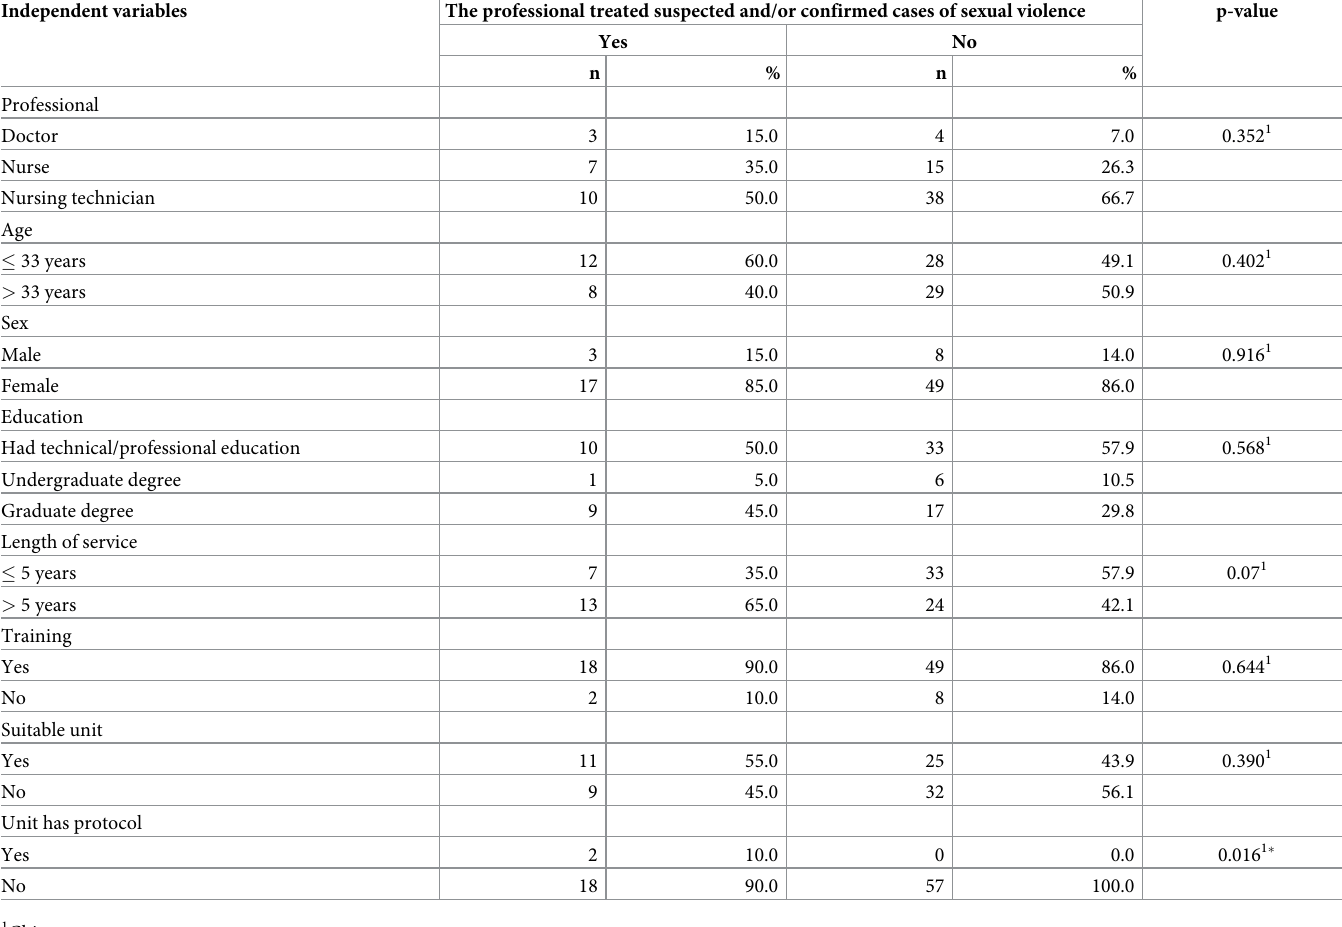
Table 2. Associations between care for survivors of sexual violence and independent